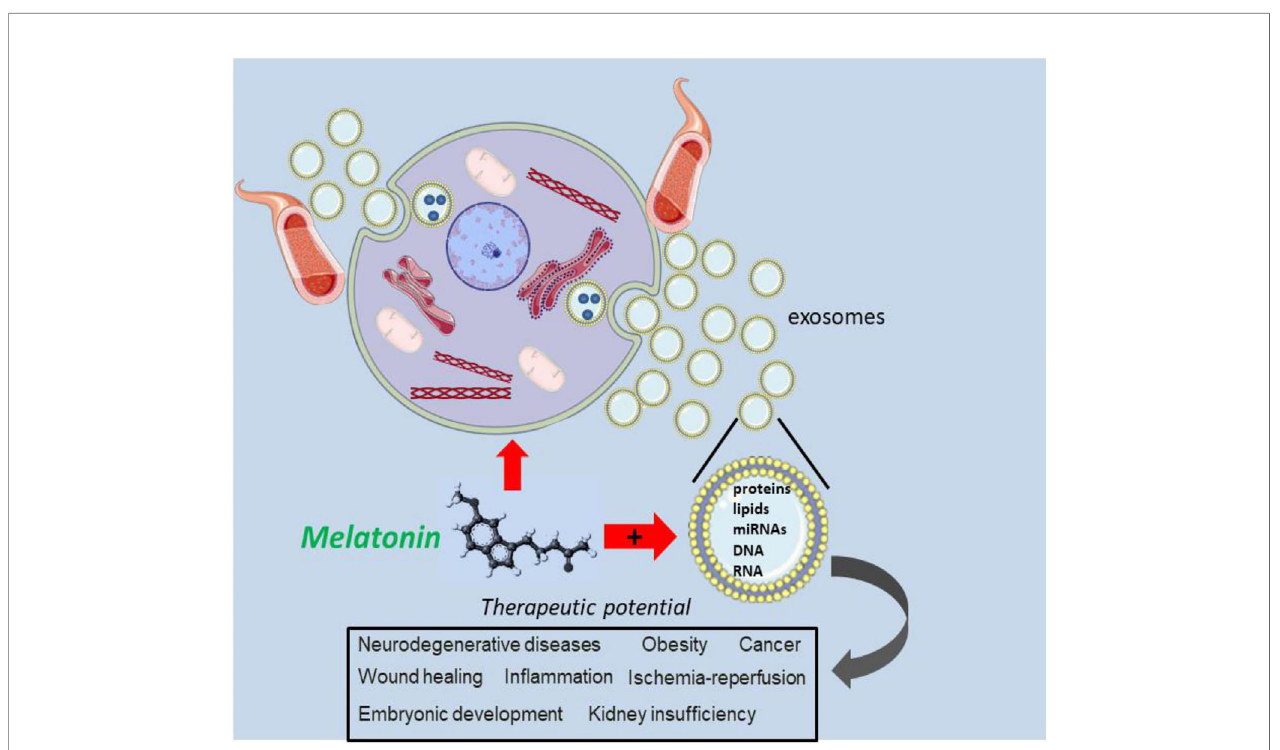
FIGURE 1 | The combination of melatonin and exosomes is promising therapeutic strategy. By acting directly on damage cells, melatonin is thought to intracellulary interface with exosome traf fi cking, possibly by modifying their molecular contrent. The user of melatonin in combination with an exosomes may be an important approach to alter the biology of exosomes related to dysregulated signaling pathways in several pathologies and disease